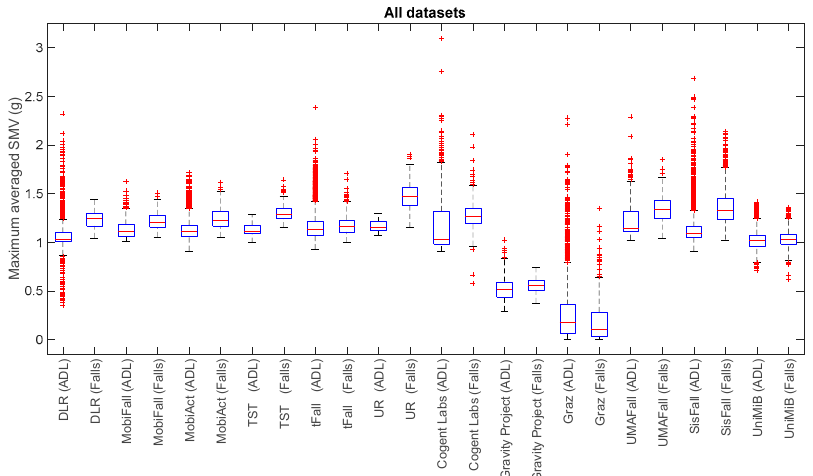
Figure 4. Boxplots of the maximum averaged acceleration magnitude (considering a sliding window of 1 s) for the falls and ADLs of all the datasets (for all the datasets only the acceleration signal at the waist or—if not available—at the thigh is considered).